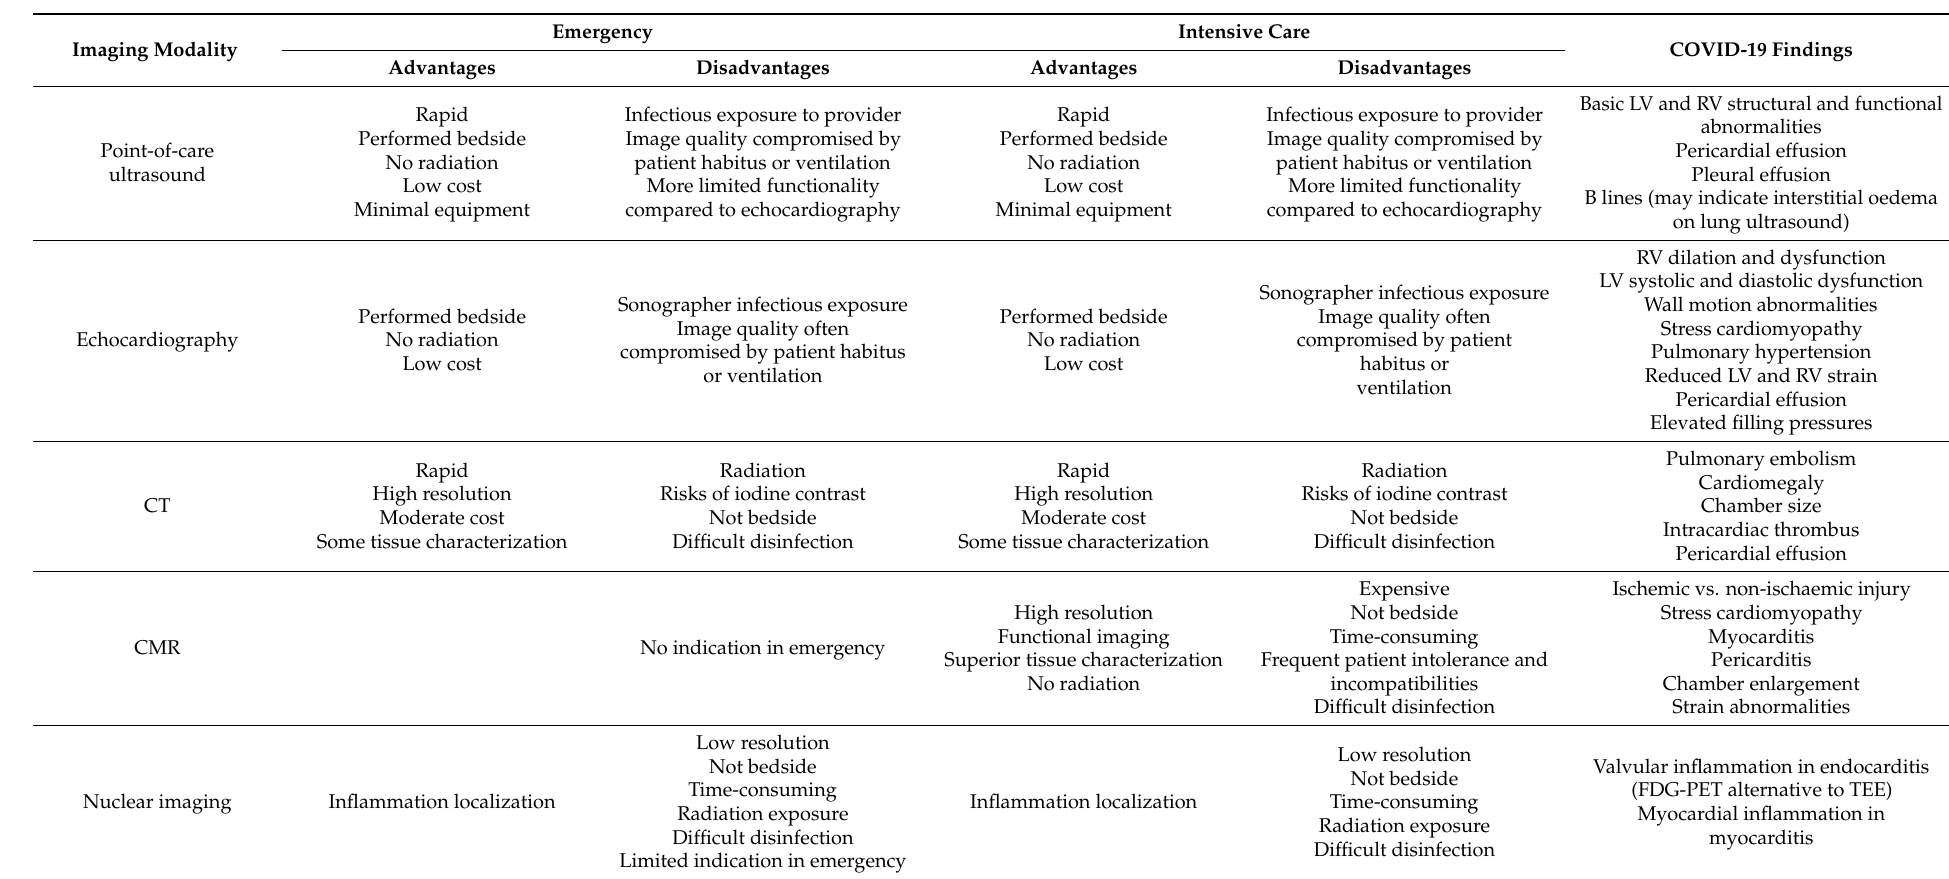
Table 1. Characteristics of each imaging modalities for care of COVID-19